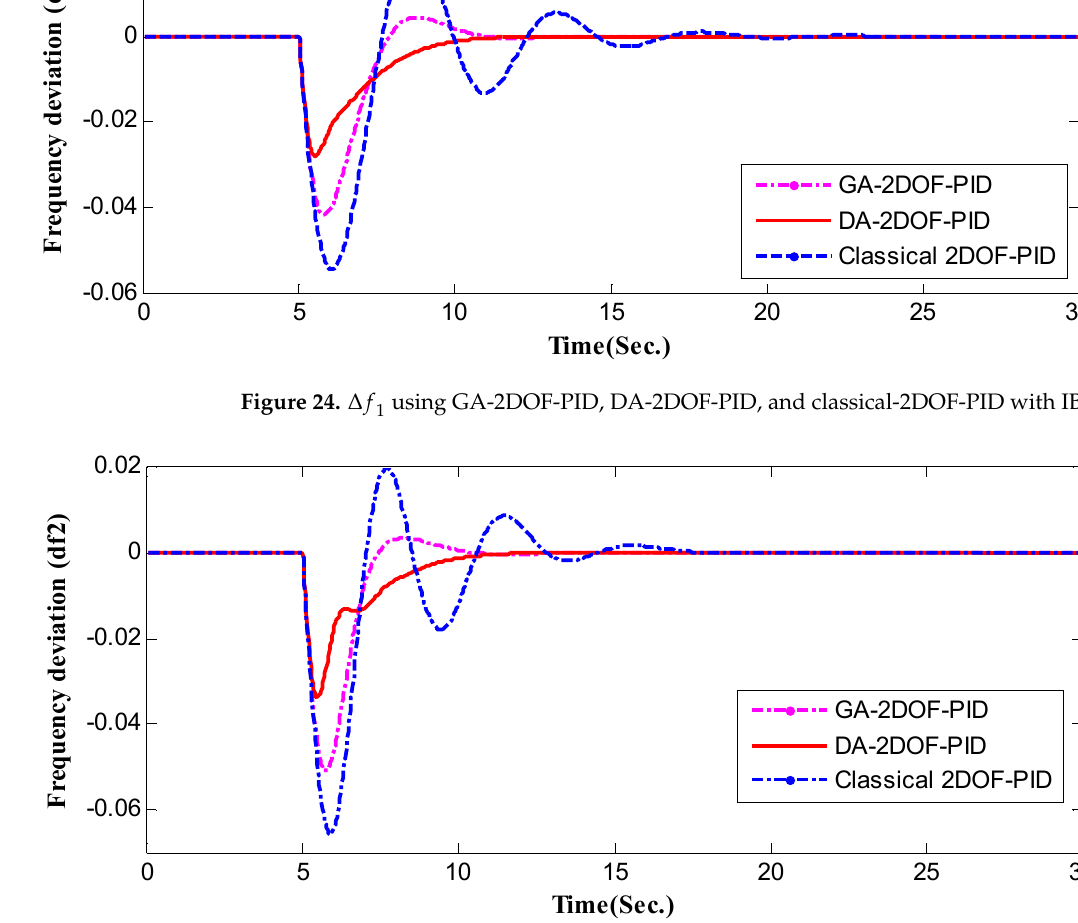
Figure 25. Δf (cid:2870) using GA-2DOF-PID, DA-2DOF-PID, and classical-2DOF-PID with IB-WGFF.